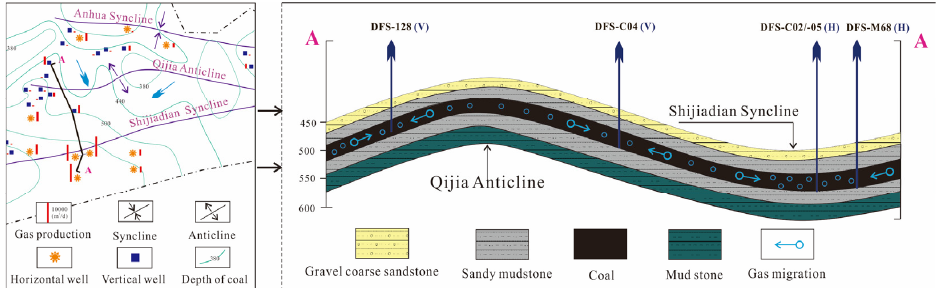
Figure 16. High-production model of CBM.